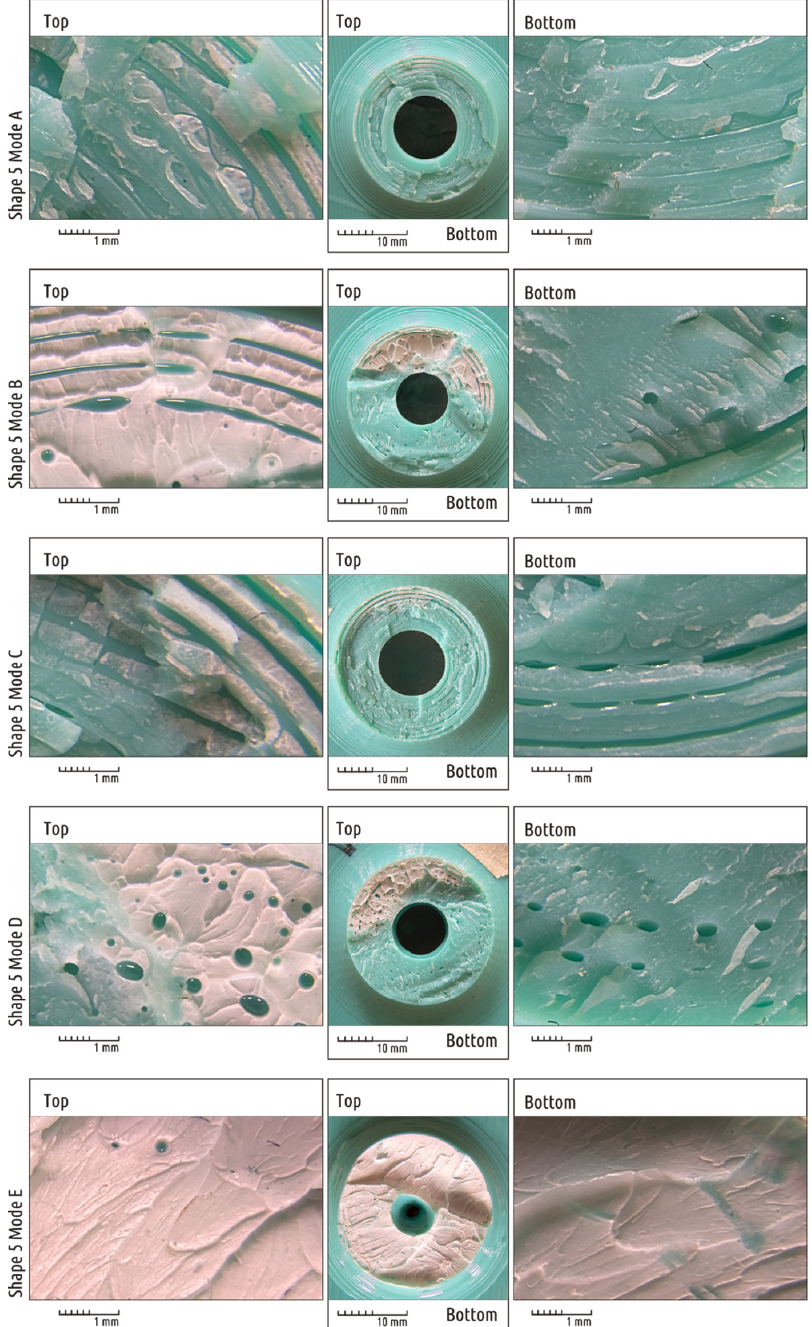
Figure 11. Fracture surface macrostructure of Shape 5 samples manufactured in di ff erent modes. “Top” and “Bottom” marks correspond to the position of the specimen at the time of destruction (the load was applied to the “top” surface of the shaft). An image of the entire fracture surface is given in the center for each sample. The fragments from the upper and lower parts are zoomed in to the left and to the right,